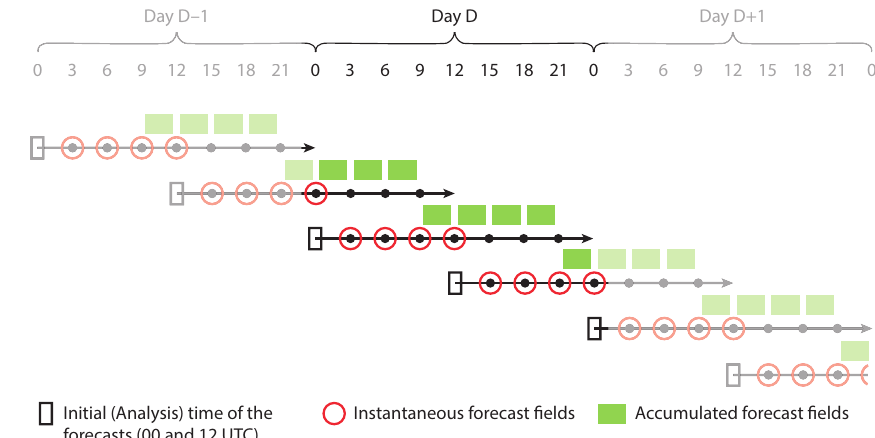
Figure 1. Schematic representation of the ERA-Interim meteorological forecasts concatenation for the creation of the 3-hourly forcing time series used in ERA-Interim/Land for a given day. Orange circles indicate instantaneous variables valid at their time stamp: 10m temperature, humidity, wind speed, and surface pressure. Green boxes indicate fluxes valid on the accumulation period: surface incoming short-wave and long-wave radiation, rainfall, and